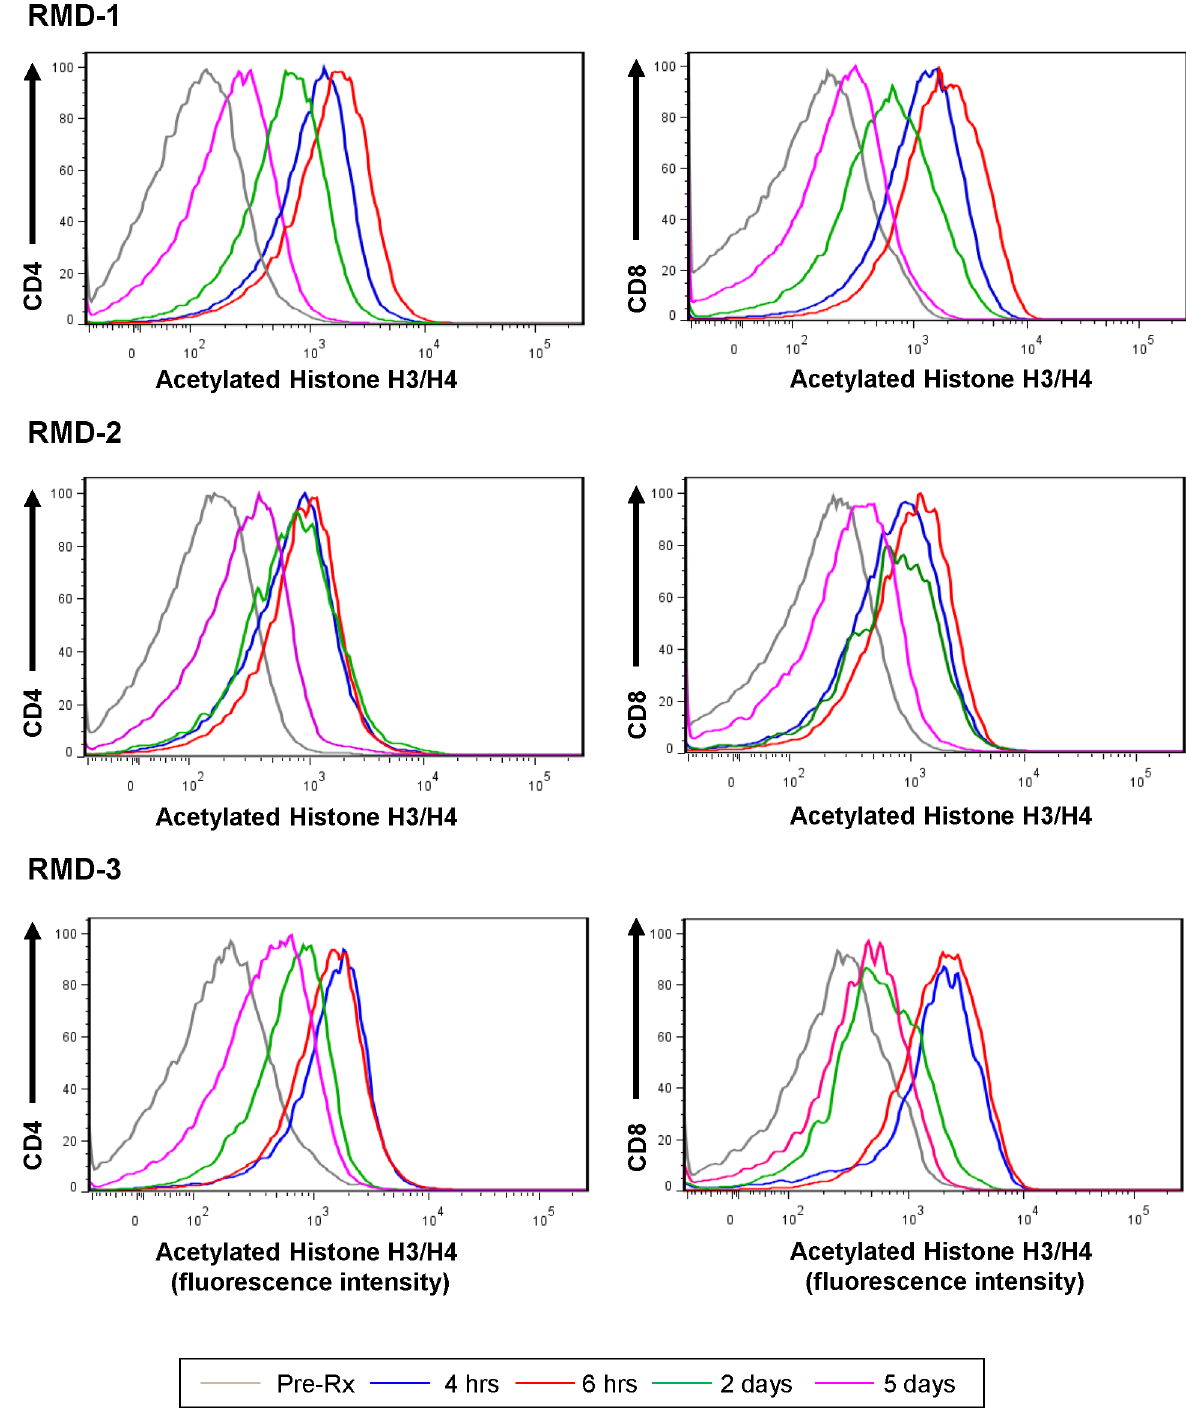
Fig 3. Romidepsin increases the levels of acetylated histones in RMs. The levels of acetylated histones have been measured by flow cytometry prior to RMD administration, and at 4 hrs, 6 hrs, 2 days and 5 days after RMD administration. Testing was performed after the first, the second and the third RMD administration. Only the results from RM135 were shown, but data were representative for all animals receiving RMD.